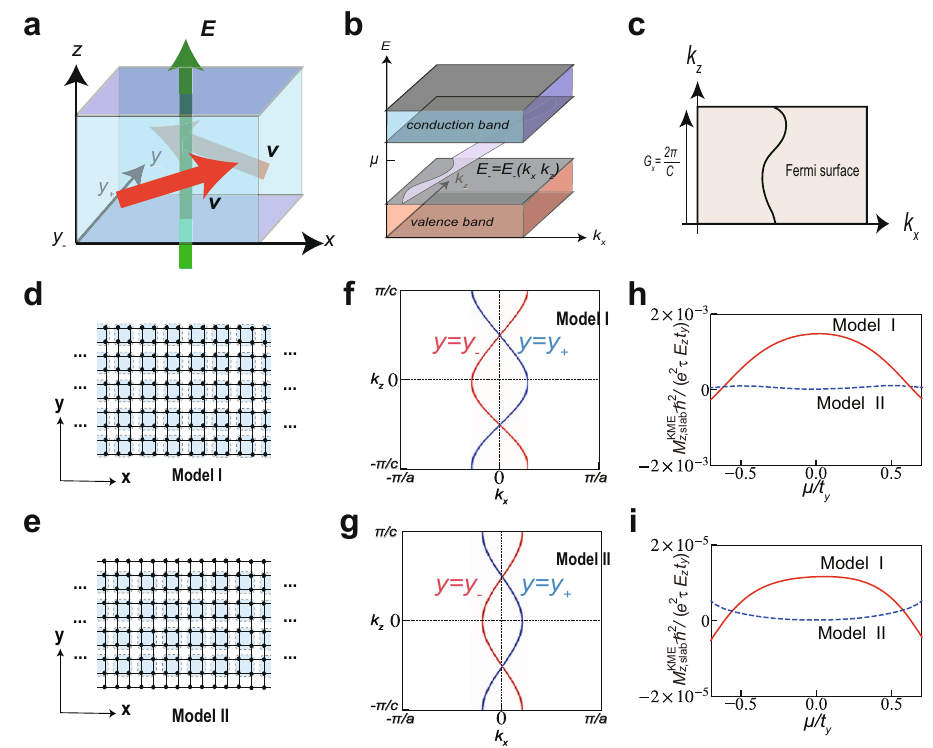
Fig. 2 Chern insulator with a chiral structure and its kinetic magnetoelectric effect (KME) in slab systems. a Surface velocities (red arrow) of the topological surface states under an electric fi eld E (green arrow). b , c Band structure of the topological chiral surface states on the y = y − surface. Their ( b ) dispersion and ( c ) Fermi surface are shown. In b , the valence and conduction bands are represented by orange and blue boxes, and the topological surface states are drawn in purple in between the two bands. c is the Fermi surface, which is a section of b at the energy E equal to the chemical potential μ . d Slab models I and with chiral hopping on the surface. Only the section along the xy plane is shown. The dots are the sites of the tight-binding model, and the blue boxes represent the unit cells, as shown in Fig. 1 a . e Slab model II with no chiral hopping on the surface. The symbols are the same as ( d ). f , g The Fermi surfaces for the slab models ( f ) I and ( g ) II with parameters t x = t y = m = b x = b y , t 3 = 0.1 t y , t 4 = 0.15 t y , and μ = 0. The red and blue curves represent Fermi surfaces on the y = y − and y = y + planes, respectively. h , i KME for the slab models I and II, shown as red solid lines and as blue broken lines, respectively, with parameters ( h ) t x = t y = m = b x = b y , t 3 = 0.1 t y and t 4 = 0.15 t y and ( i ) t x = t y = m = b x = b y , t 3 = 0.001 t y and t 4 = 0.15 t y .